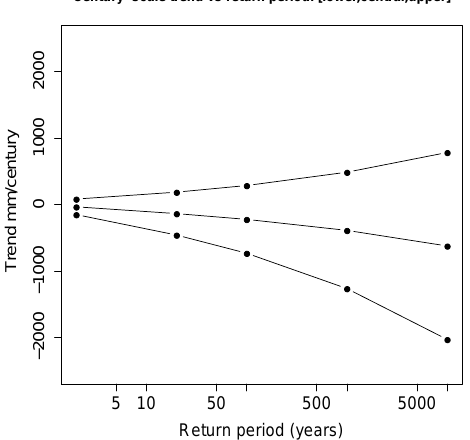
Figure 10. Projected century-scale trends in significant wave height for five return periods due to storminess changes only (i.e. excluding mean sea level change;mm per century). Central, lower and upper estimates are